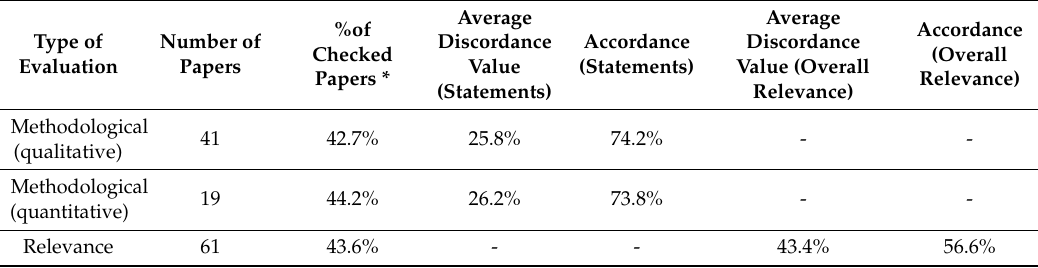
Table A1. Inter-coder-reliability: evaluation of accordance of the methodological and the relevance screening.